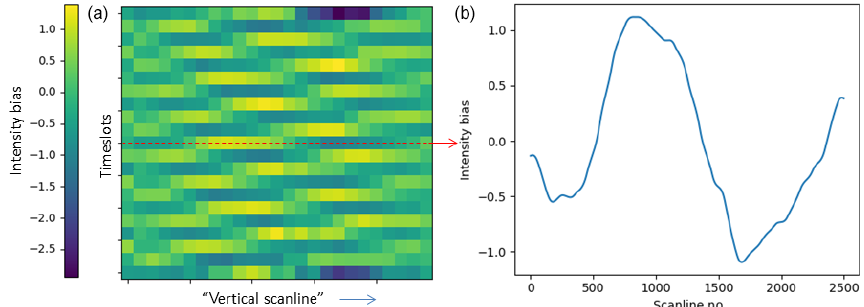
Figure 10. Example of the Meteosat-5 optical hardware issue in time, where the image (a) shows the anomaly’s bias for consecutive images across the scan lines. The image (b) is for a particular time slot and shows the anomaly’s bias across the scan lines. Taken from METEOSAT5- MVIRI-MTP10-NA-NA-19960515120000 and channel IR (©EUMETSAT). Table 4. Percentage of level 1.0 files containing anomalies in the images and